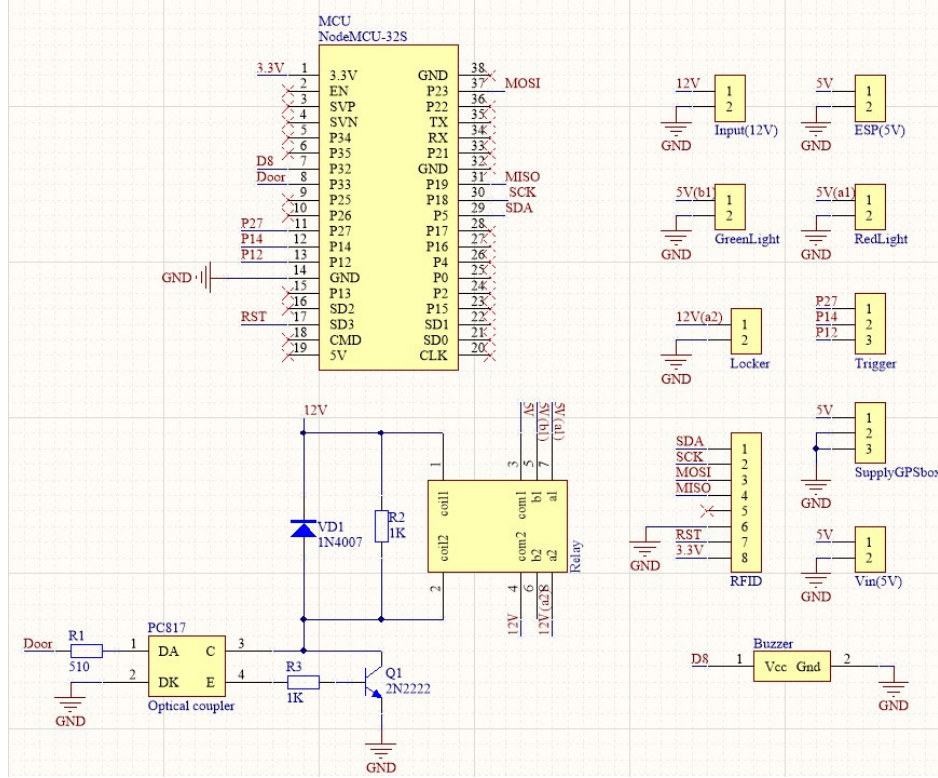
Figure 20. Entity diagram of an independent key cabinet.